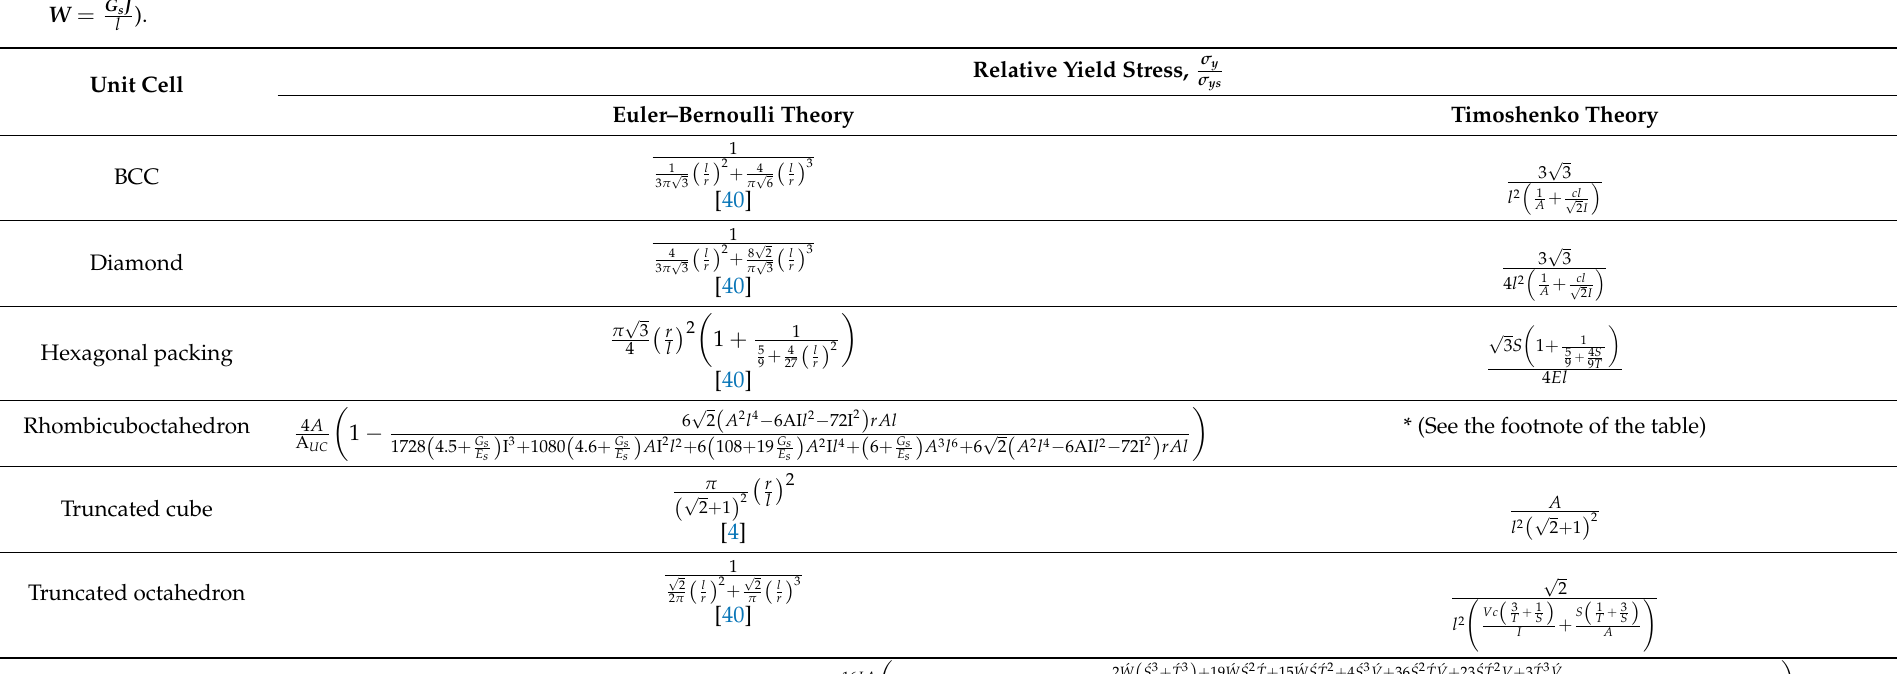
, = 1 , U = 1 l l 3 + l κ AGs 12 EsI